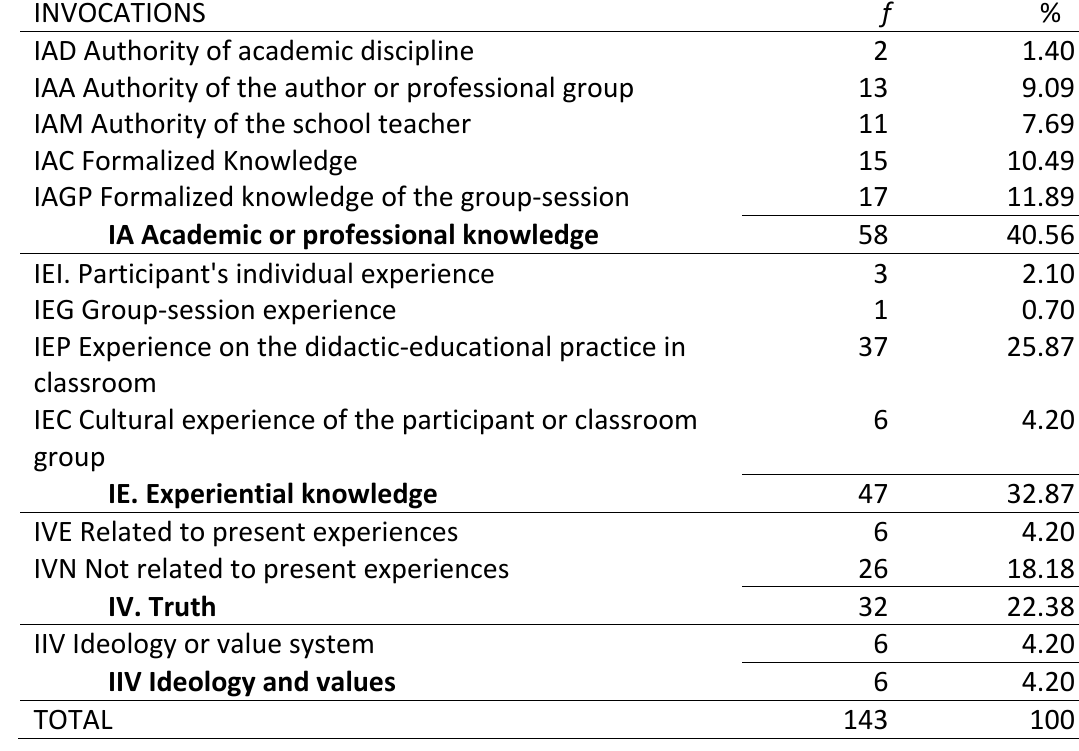
Table 3. Overall profile of invocations in case